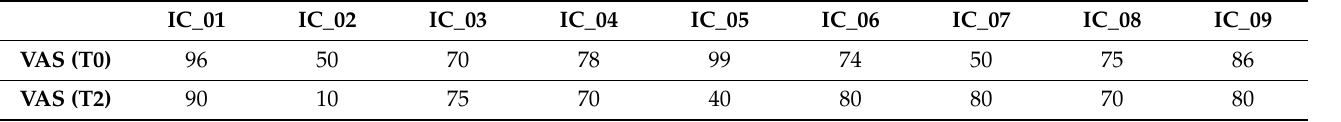
Table 6. VAS scores of informal caregivers at the beginning and at the end of the